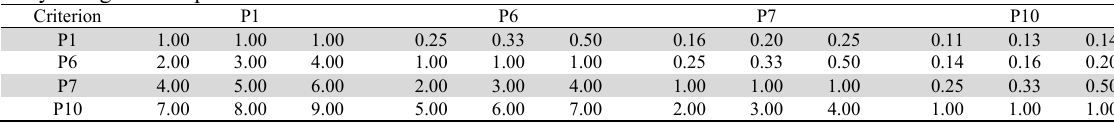
Saaty pairwise comparisons Category